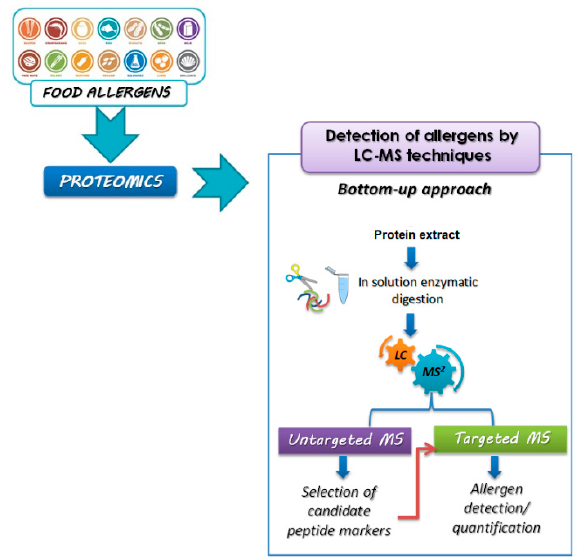
Figure 1. Overview of proteomic pipelines based on bottom-up strategies for food allergen quantification .